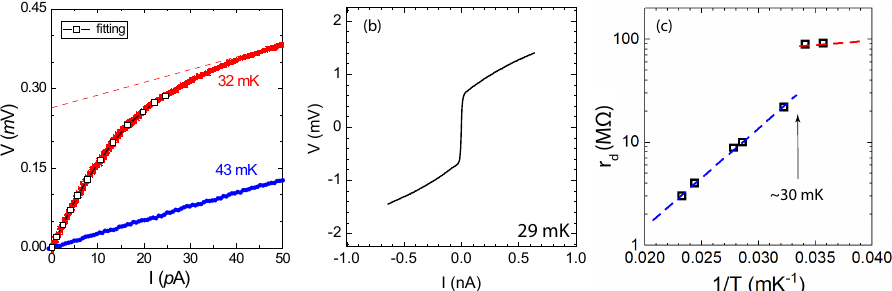
Figure 3. ( a ) Nonlinear and linear DC-IV for r s = 53 at 32 and 43 mK within a current window up to 50 p A. Dashed line is a guide for the eye. ( b ) Threshold DC-IV obtained at 29 mK for the same r s ( c ) Piecewise behavior of r d ( T ) displayed in log ( r d ) vs. 1/ T